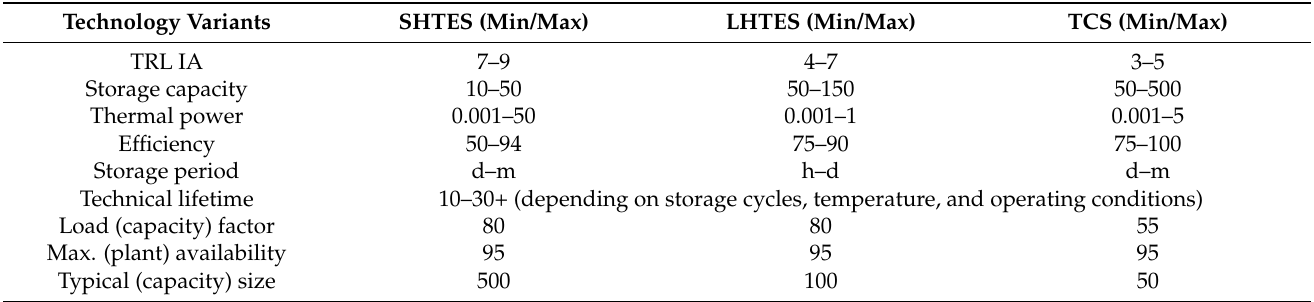
Table 8. Current typical values of technical performance of TES.